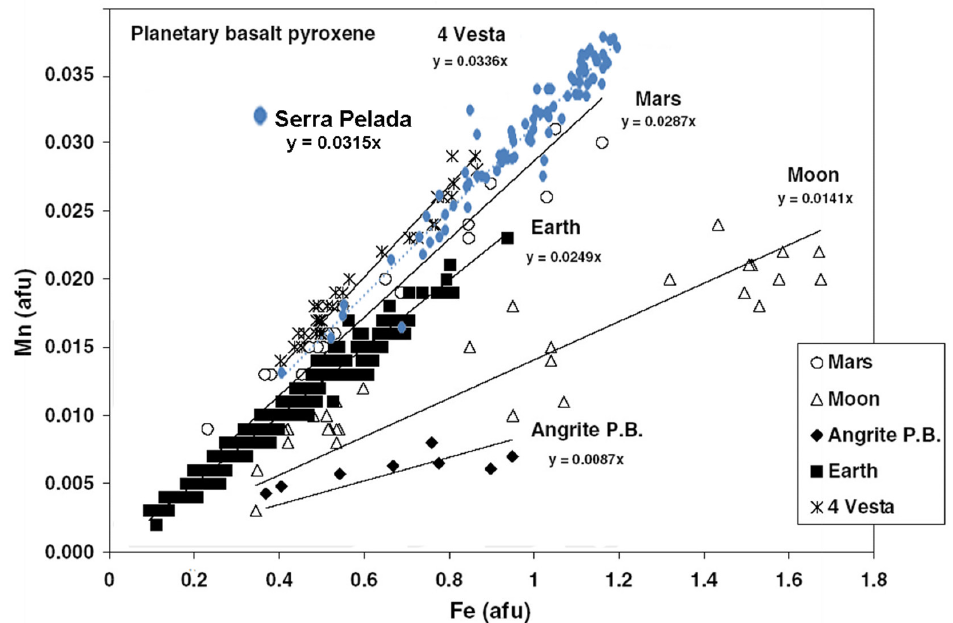
Figure 7 - Fe vs. Mn per 6-oxygen formula unit for pyroxene from planetary basalts, modified from Papike et al. (2003). The angular coefficient of Serra Pelada fits well with an origin from asteroid 4 Vesta.